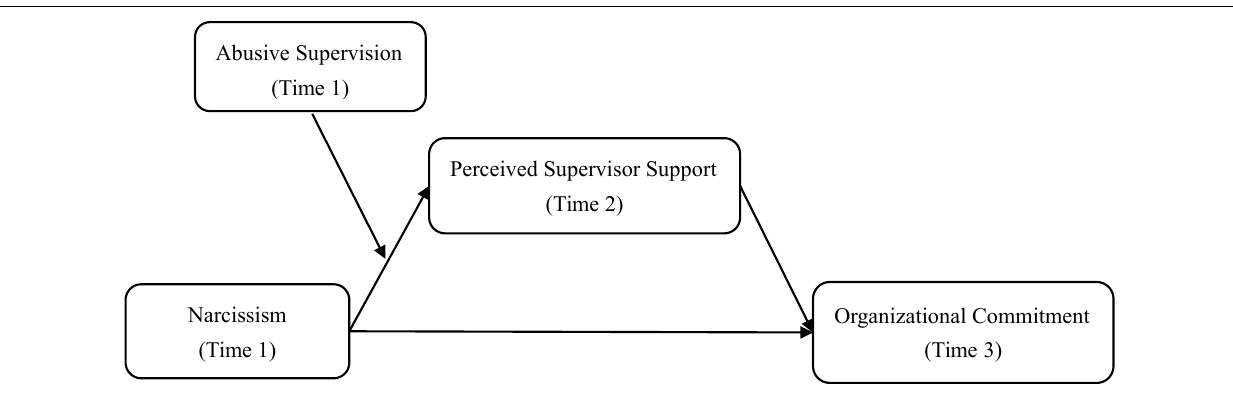
FIGURE 1 | Proposed